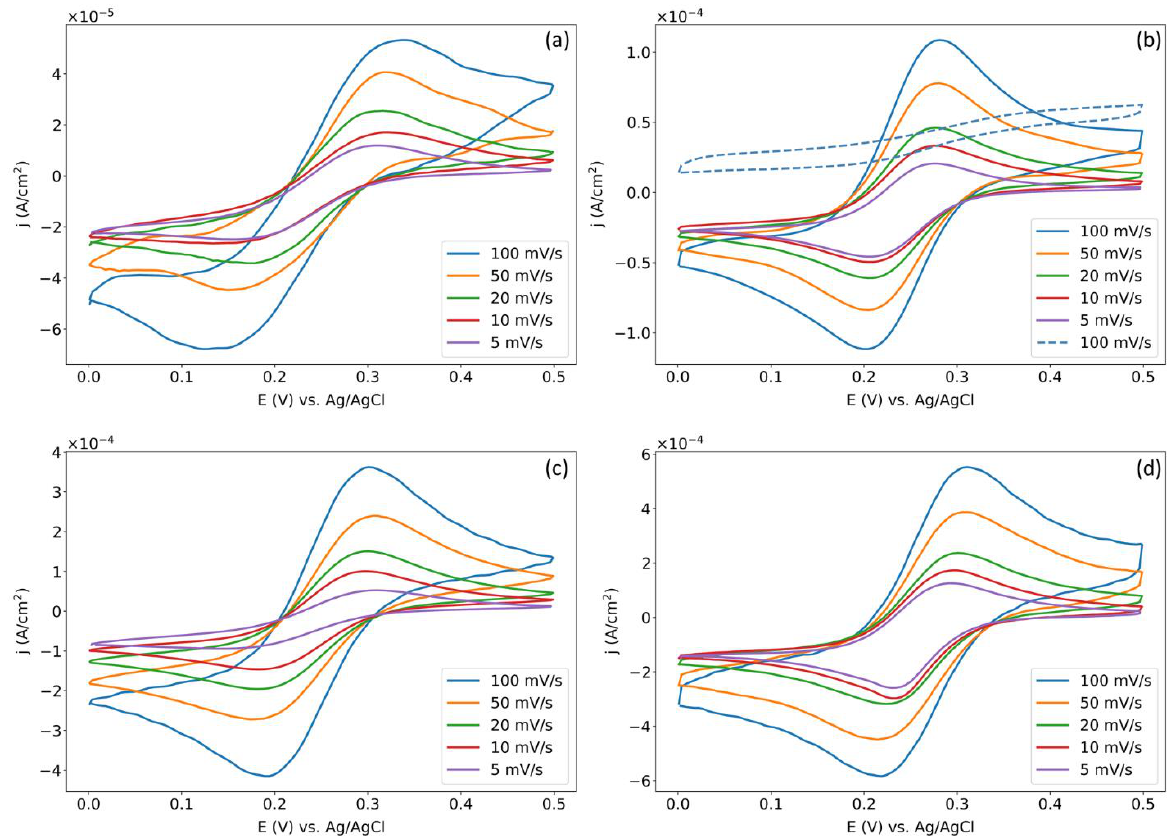
Figure 3. Cyclic voltammograms of Au stripes on chip, at different scan rates (legend), for different concentrations of potassium ferricyanide: ( a ) 0.5 mM, ( b ) 1 mM, ( c ) 3 mM, ( d ) 5 mM. The dash-dot curve in ( b ) corresponds to a CV measurement for electrodes that were not burned-in (cf. electromigration section).